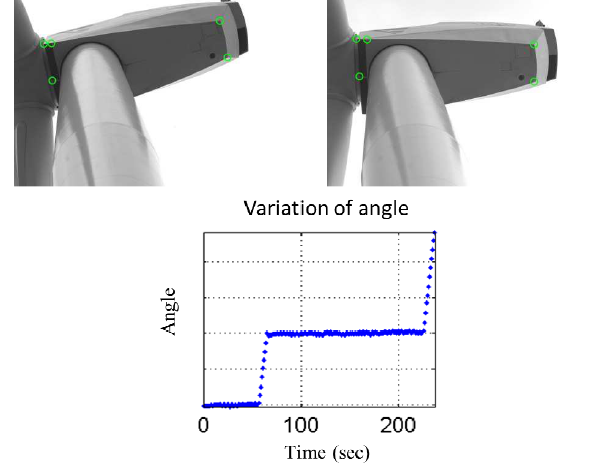
Figure 9. Rotation of the